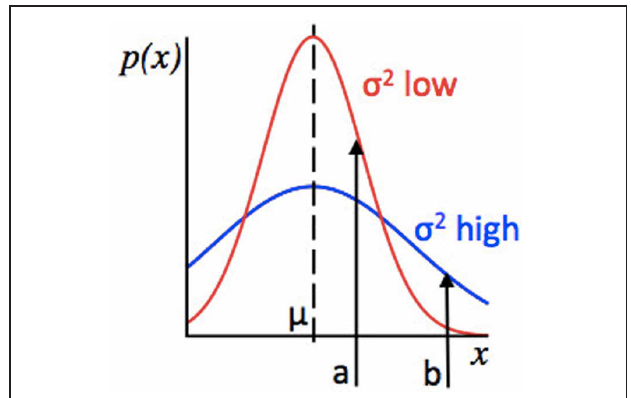
FIGURE 2 | Relationship between the concepts of Expected Uncertainty and Likelihood. Plot of values of some observed variable x against their probability, given two Gaussian distributions with the same mean. The red distribution has a lower variance, and hence lower expected uncertainty, than the blue distribution. Points a and b represent possible observed values of x . For the red and blue distributions, the distance from the mean ( a − μ ) is the same, but at a , the red distribution has higher likelihood (because point a has a higher probability under the red distribution than the blue distribution) whilst at point b , the blue distribution has a higher likelihood. Consider an algorithm assessing evidence that the environment has changed. If a datapoint x = b is observed, whether the algorithm infers that there has been a change will depend on the variance or expected uncertainty of the putative pre-change distribution. If the algorithm “thinks” that the red distribution is in force, an observation x = b is relatively strong evidence for a change in the environment (as b is unlikely under the red distribution) but if the algorithm “thinks” the blue distribution is in force, the evidence for change is much weaker, since point b is not so unlikely under the blue distribution as it is under the red